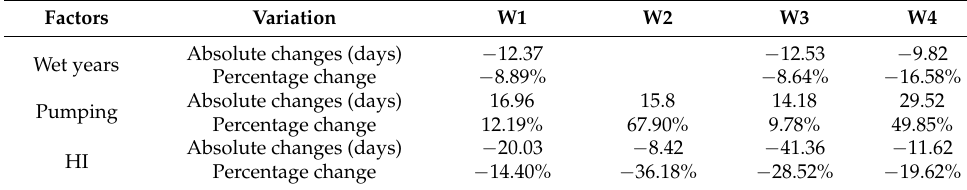
Table 7. Variation in time lags due to different factors.